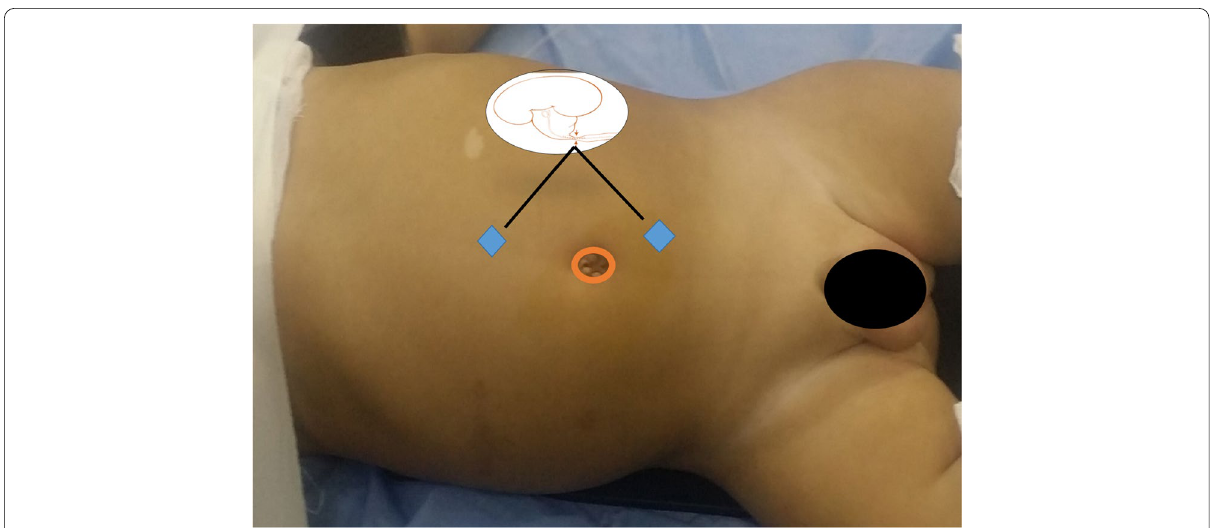
Fig. 2 Port sites for laparoscopic transperitoneal